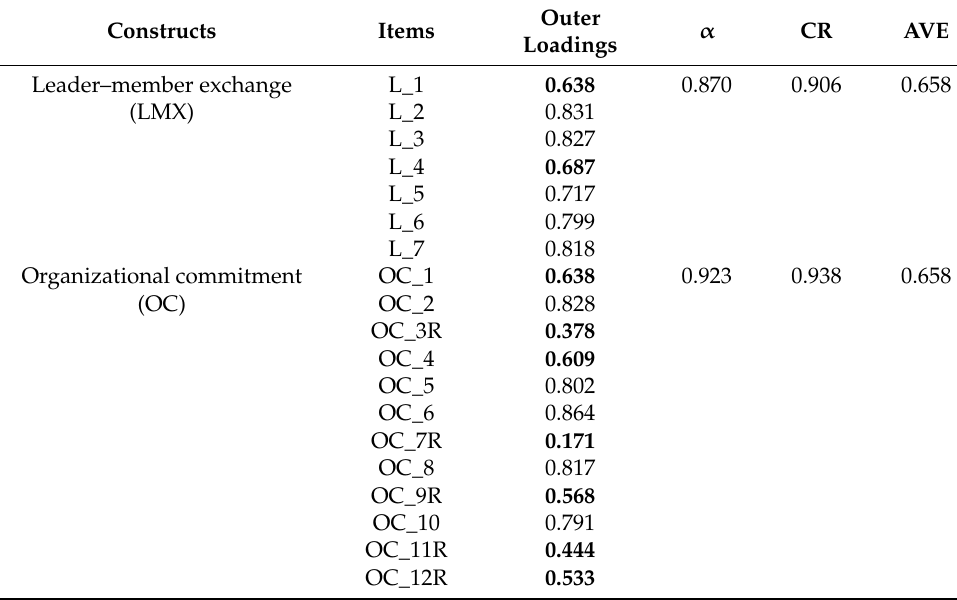
Table 2. Convergent validity and internal consistency